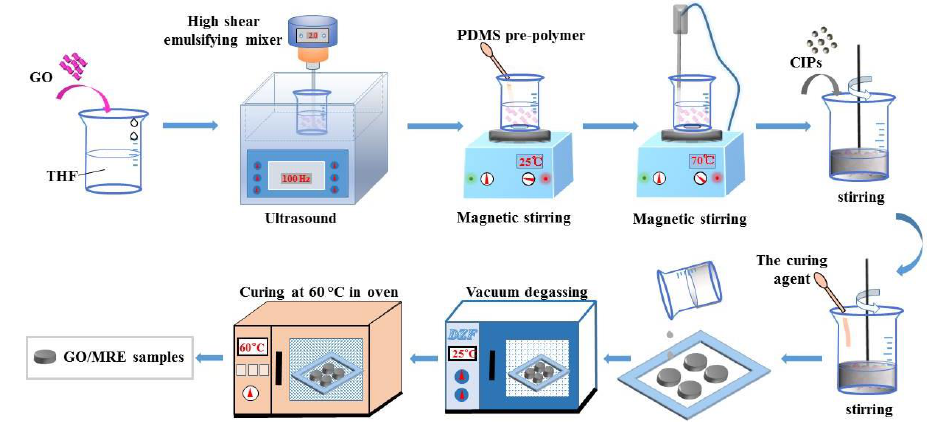
Figure 1. Schematic of the fabrication procedure for the isotropic GO-filled MREs. Four isotropic PDMS-based MREs filled with the GO fractions of 0, 0.1, 0.3 and 0.5 wt.% were produced, which are referred to here as MRE-0, MRE-1, MRE-3 and MRE-5, respectively. The mass fraction of CIPs in the MREs was 60%. Here, the highest GO fraction was 0.5 wt.% because more GO sheets made the GO/PDMS pre-polymer emulsion highly viscous, thus preventing CIPs from uniformly dispersing in the emulsion and the GO-filled MREs from solidifying.